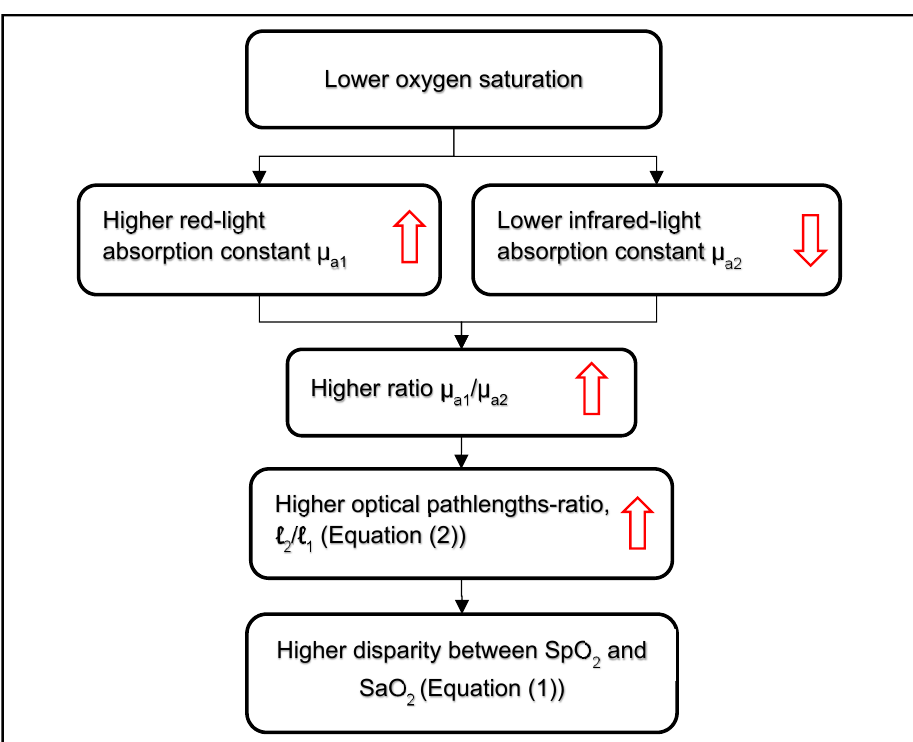
Figure 6. Flowchart describing the relationship between hypoxemia and the overestimation of SaO 2 by SpO 2 . The steps are described in detail in the text.